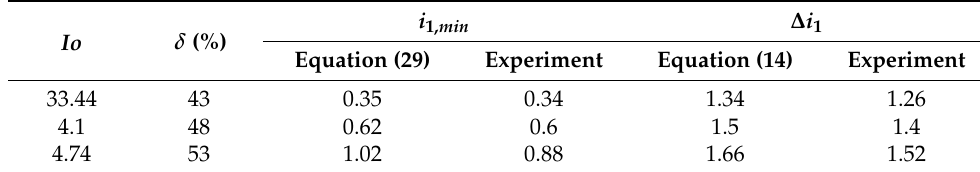
Table 7. Comparison of CCM current.